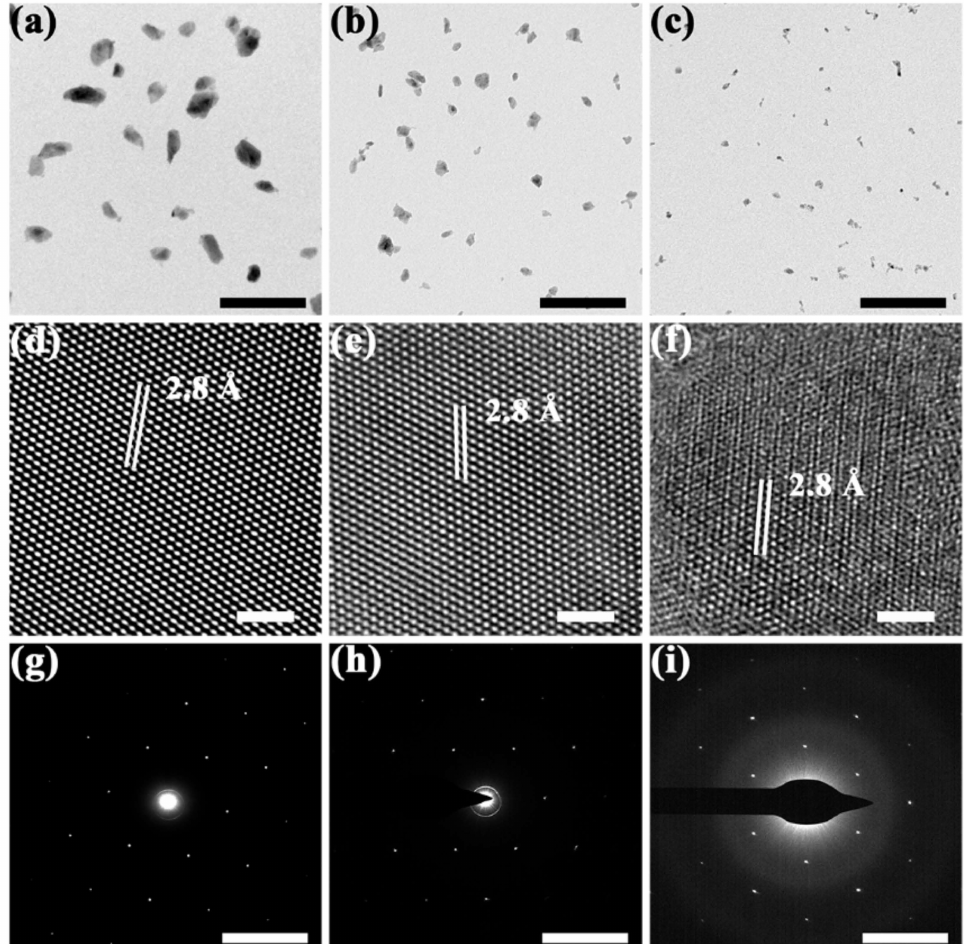
Figure 1. ( a – c ) TEM, ( d – f ) HRTEM, and ( g – i ) SAED images of WSe 2 NSs with different sizes prepared by CMC–assisted ball milling at different centrifugation speeds: ( a , d , g ) WSe 2 –Low (10,000 rpm for 1 h), ( b , e , h ) WSe 2 –Medium (16,000 rpm for 1.5 h), ( c , f , i ) WSe 2 –High (21,000 rpm for 4 h). Scale bars: 200 nm for ( a – c ), 2 nm for ( d – f ), and 5 1/nm for ( g – i